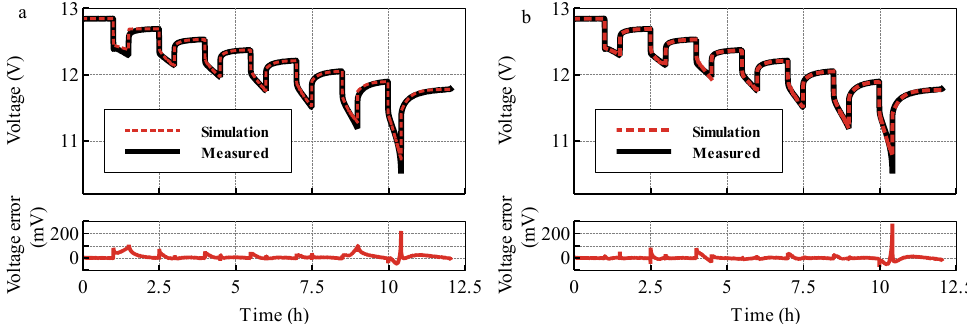
Figure 7. Parameter estimation process for the SLA battery. ( a ) Initial Parameter estimation using the linear least-square method, ( b ) Final Parameter estimation using nonlinear-least square optimization.